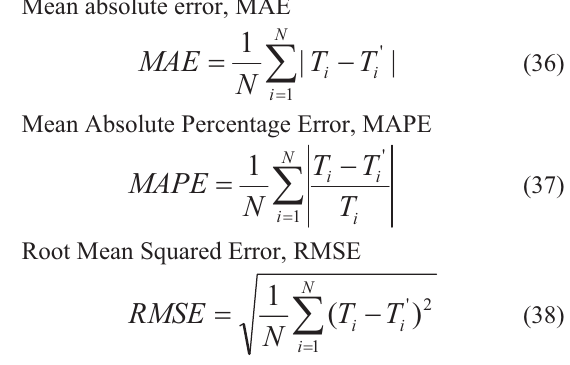
1 and the initial particle velocity is randomly chosen from genetic algorithm P P m,max